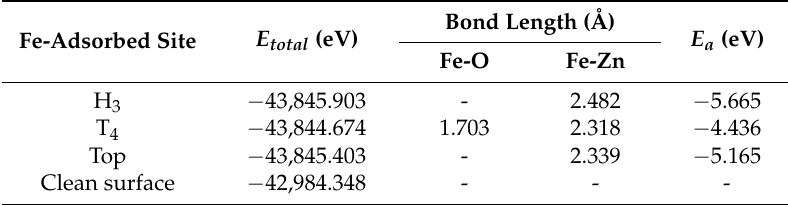
Table 2. The total energy, bond length, and adsorption energy (eV) of the iron-adsorbed ZnO (0001)